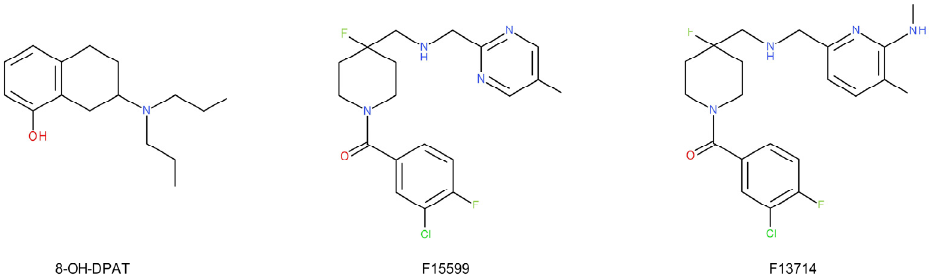
Figure 2. 5-HT 1A receptor agonists: 8-OH-DPAT, F15599, and